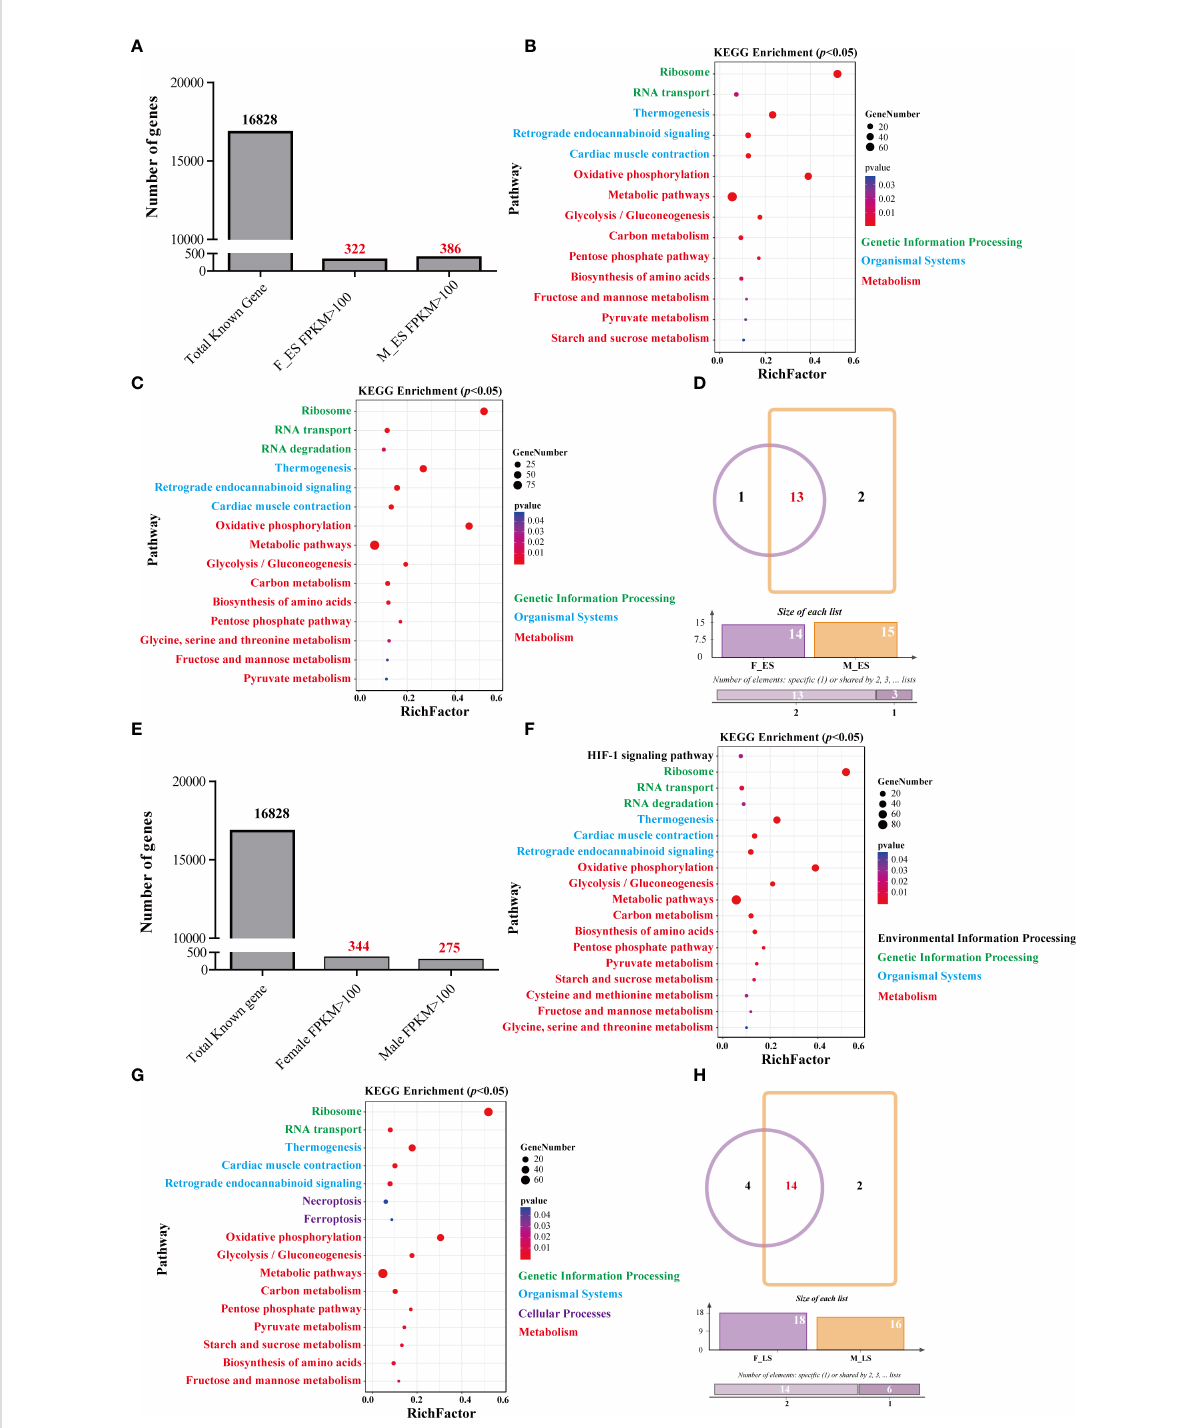
FIGURE 4 The annotation and function analysis of highly expressed genes. (A) The numbers of highly expressed genes in males and females during the ES. (B) The enrichment pathway of highly expressed genes in females during the ES. (C) The enrichment pathway of highly expressed genes in males during the ES. (D) The Venn diagram of the pathways of highly expressed genes in males and females during the ES. (E) The number of highly expressed genes in males and females during the LS. (F) The enrichment pathway of highly expressed genes in females during the LS. (G) The enrichment pathway of highly expressed genes in males during the LS. (H) The Venn diagram of the pathways of highly expressed genes in males and females during the